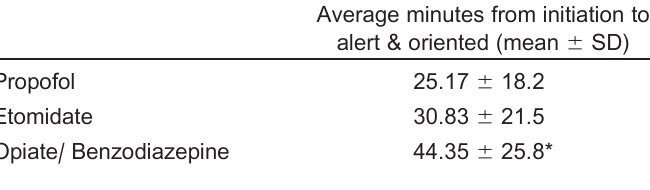
Table 4. Length of procedural